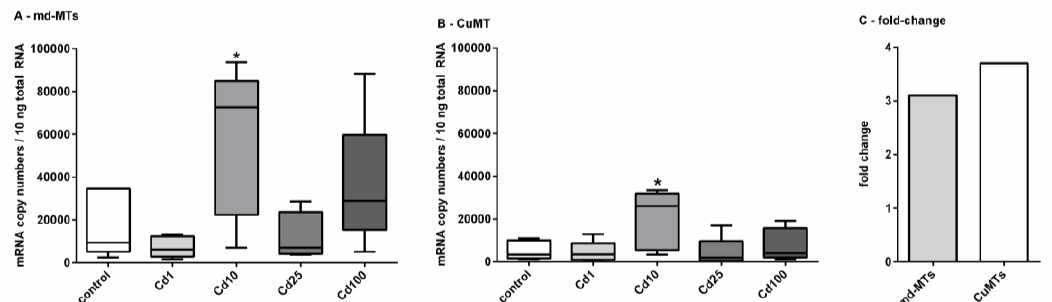
Figure 5. Impact of Cd exposure on MT gene transcription in A. biplicata . Whisker box plots for mRNA copy numbers are given for ( A ), showing the joined transcriptional upregulation of the two md-MT genes ( 9md-MT + 10md-MT ) and ( B ), of the CuMT gene in controls and Cd-treated snails ( n = 5 each) from the lowest to the highest value of each treatment group. The respective box extends from the 25th to the 75th percentile, with the square line showing the median. ( C ), Bar graph reflecting the fold-change of joined md-MT and CuMT transcription in snails treated with 355.3 µg/g Cd (Cd10), referred to control levels. Cd exposure concentrations were as follows: Cd1 = 38; Cd10 = 355.3; Cd25 = 804.5; Cd100 = 2692.6 µg/g d.w. (see Section 3.2). Asterisks ( * ) indicate significance ( p < 0.05) of mRNA copy numbers referred to respective control values.